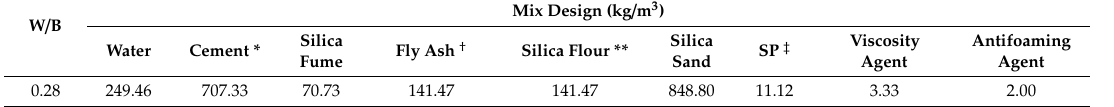
Table 3. Mix proportion of high-performance cement composites (HPCCs).